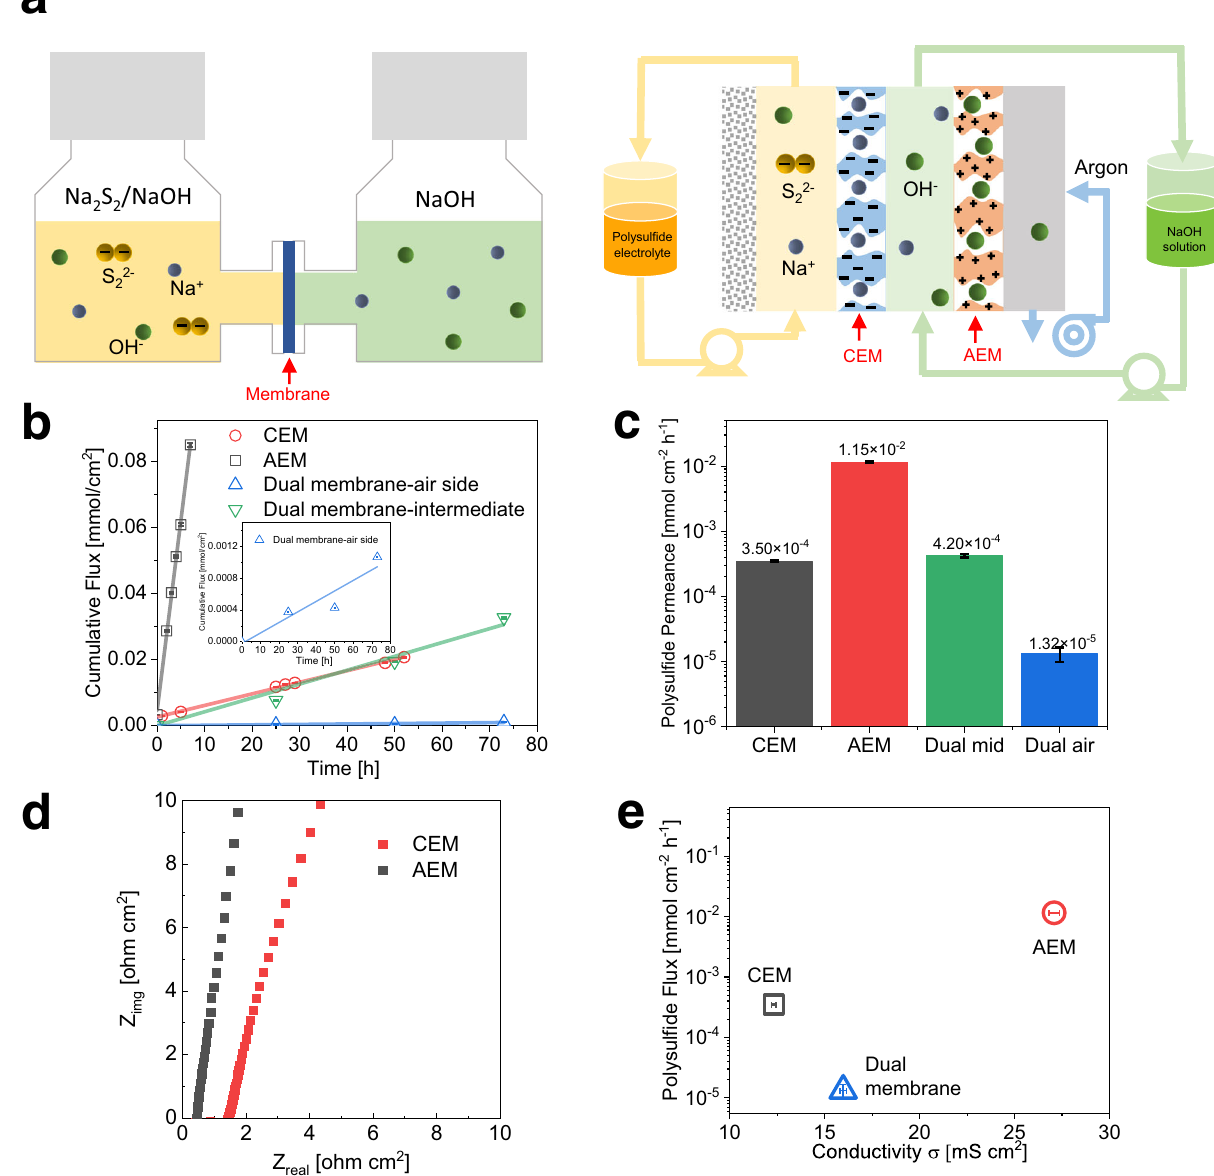
Fig. 3 Diffusion of polysul fi de species through ion-exchange membranes. a Left: H-cell setup for polysul fi de crossover determination on single-AEM (FAA-3-PK-130) and CEM (Na fi on 117); Right: redox fl ow battery setup for polysul fi de crossover determination on the dual-membrane structure. b Cumulative crossover of the permeate solution in single-AEM, single-CEM and dual-membrane setup against permeation time, inset shows the dual- membrane polysul fi de crossover measured at the air side. c Calculated polysul fi de fl ux across single-AEM, single-CEM and dual-membrane structure. d EIS of CEM and AEM. e The polysul fi de fl ux versus membrane conductivity. The error bars show the UV-Vis measurement error, conductivity measurement error and fi tting